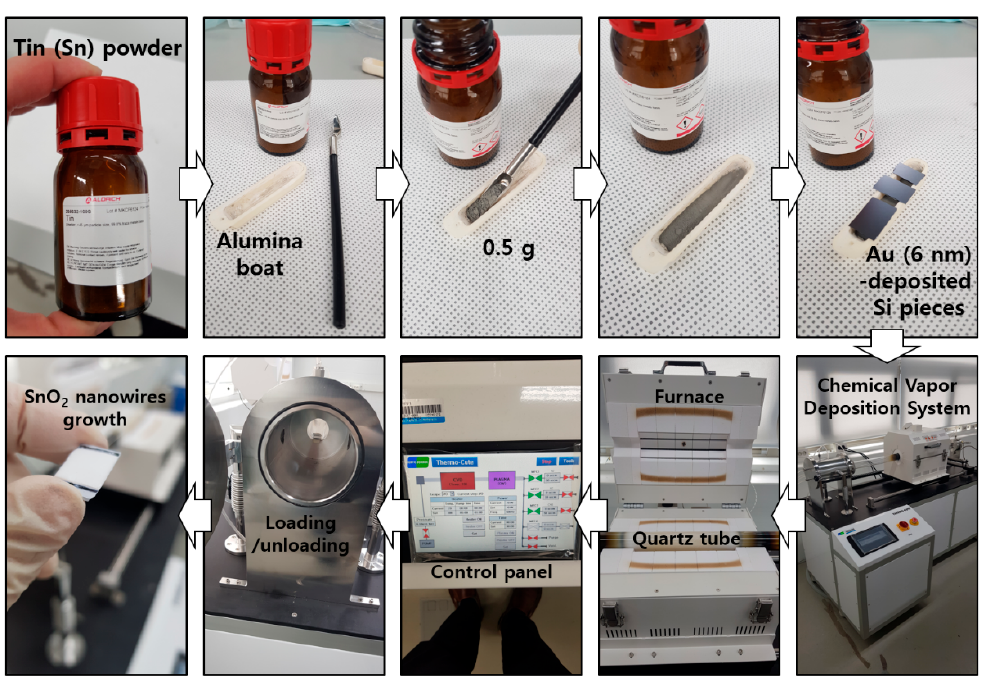
Figure A2. Structure of as-grown SnO 2 NWs: ( a ) scanning electron microscope (SEM) image of SnO 2 NWs; ( b ) X-ray diffraction (XRD) data of a rutile SnO 2 NWs.